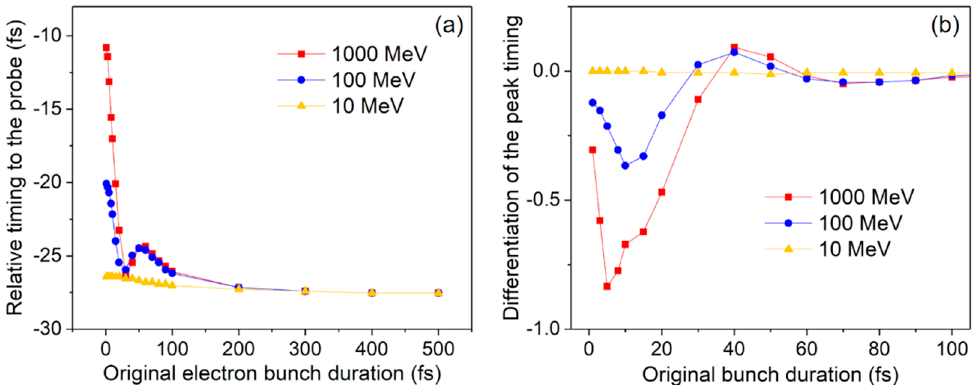
Figure 5. Discussion of the relative timing fluctuation due to electron parameter fluctuation in LWFA. ( a ) Relative EO signal timing to the probe laser. Electron bunch with energy of 1 GeV, 100 MeV, 10 MeV, and bunch duration from 1 fs to 500 fs are calculated. ( b ) The di ff erentiation of the peak timing trend in ( a ) for original bunch duration in the range of 1 to 100 fs. Distance between the detection point to the electron path is r 0 = 1.5 mm .